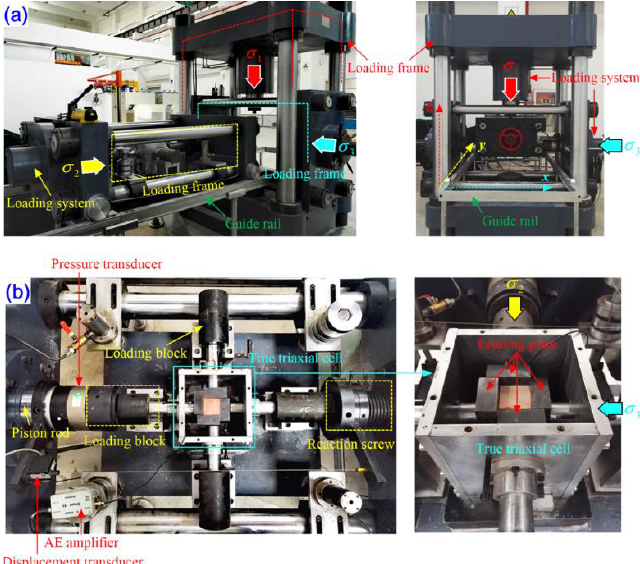
Figure 2. True triaxial compression test system: ( a ) frame of the testing machine; ( b ) internal structure of the true triaxial compression test system [28].